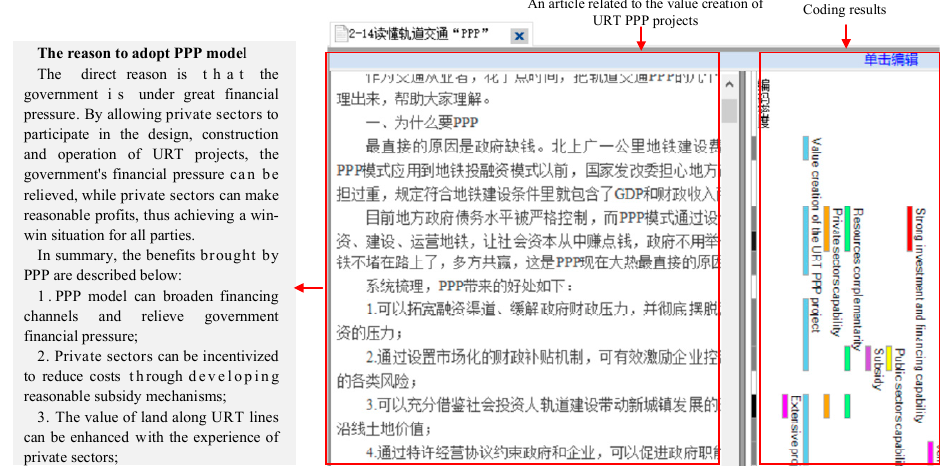
Figure 2. Open coding of one article (ID NO.2-14).